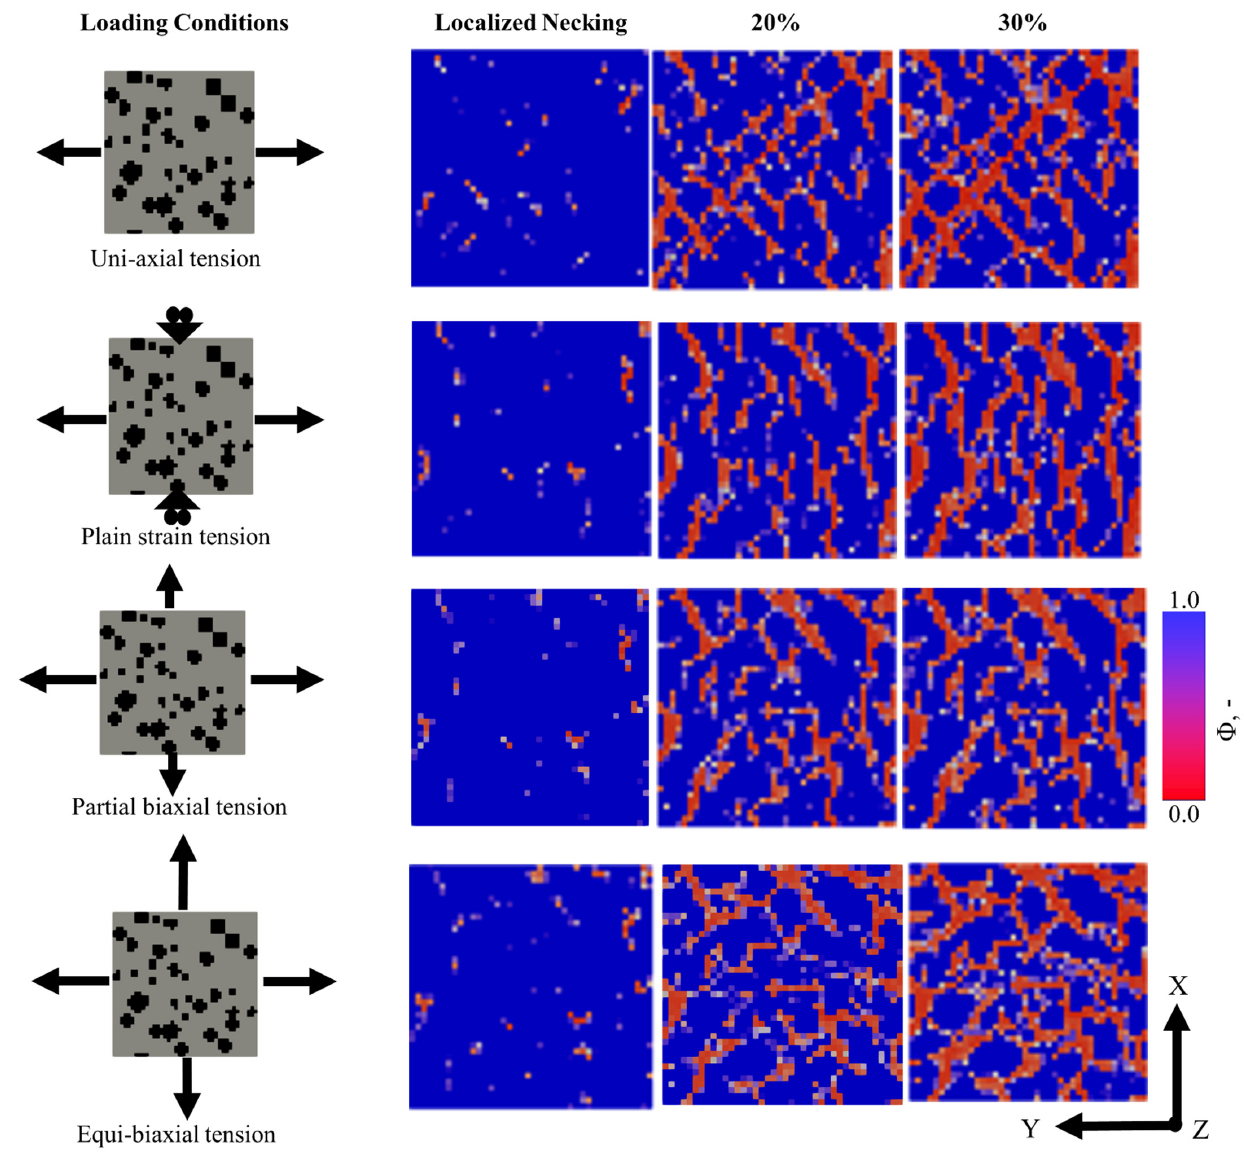
Figure 12. Damage behavior of dual-phase steels in model C with martensite grain sizes = 4